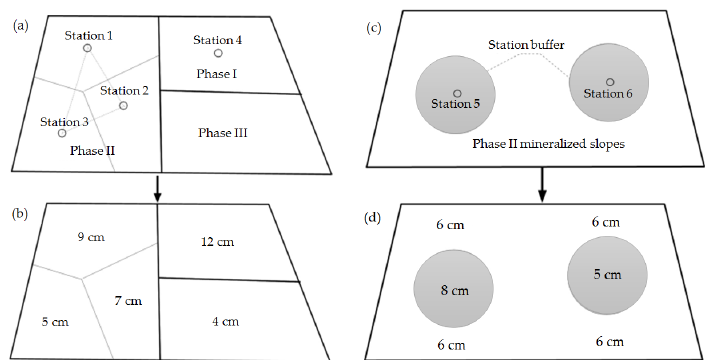
Figure 6. Mineralized block and buffer methods assignment: ( a ) geological survey stations and mineralized phases distribution; ( b ) thickness assignment of mineralized block; ( c ) geological survey station buffers and mineralized phases distribution; ( d ) station buffers assignment.